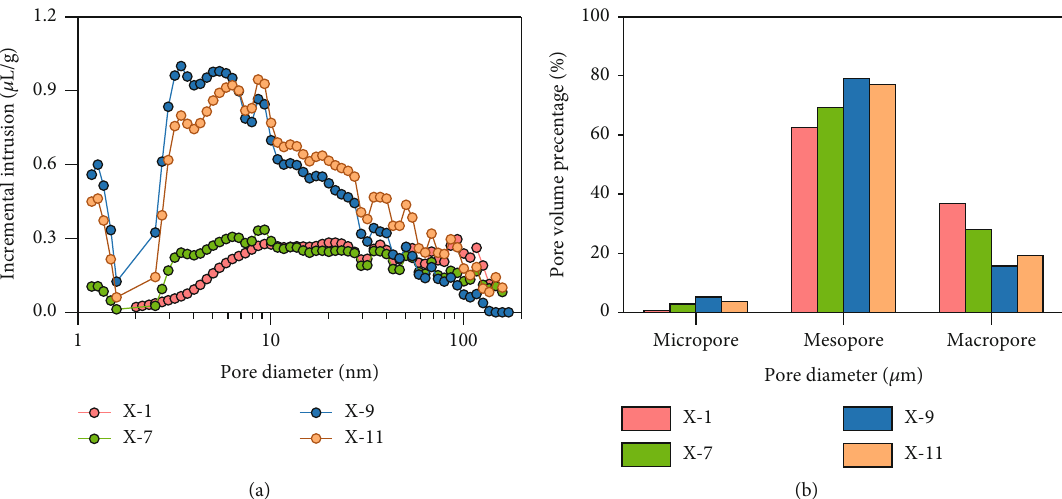
Figure 5: (a) Pore size distribution obtained from N and macropores ( > 50 nm) in di ff erent